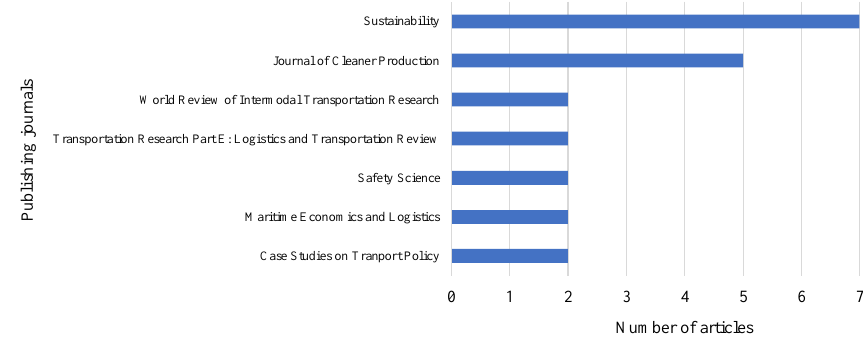
Figure 2. Research timeline. Source: personal elaboration by the authors.